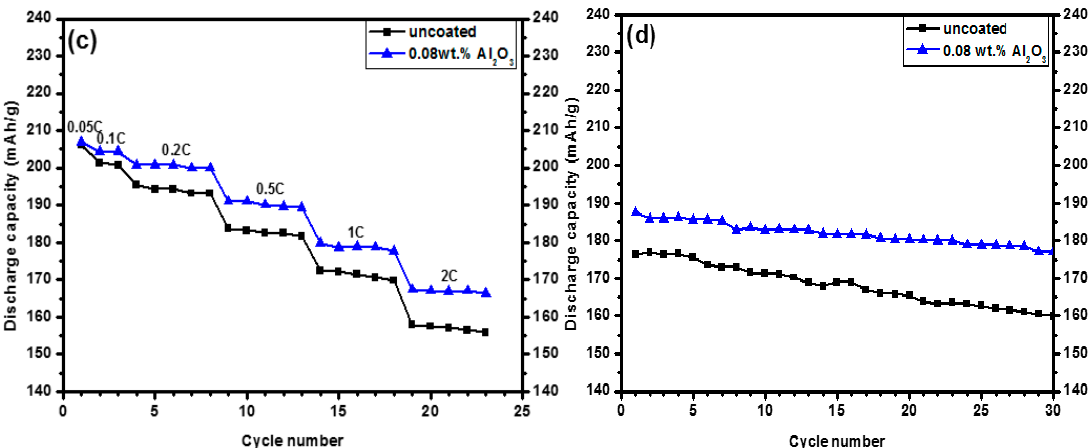
Figure 2. Electrochemical performance of the Li(Ni 0.6 Co 0.2 Mn 0.2 )O 2 samples uncoated and coated with different amounts of Al 2 O 3 annealed at 600 °C for 4 h and cycled between 3.0 and 4.5 V; ( a ) Discharge capacity vs. cycle number; ( b ) initial charge and discharge curves; ( c ) rate capability, and ( d ) cycling performance operated at a rate of 0.5C.